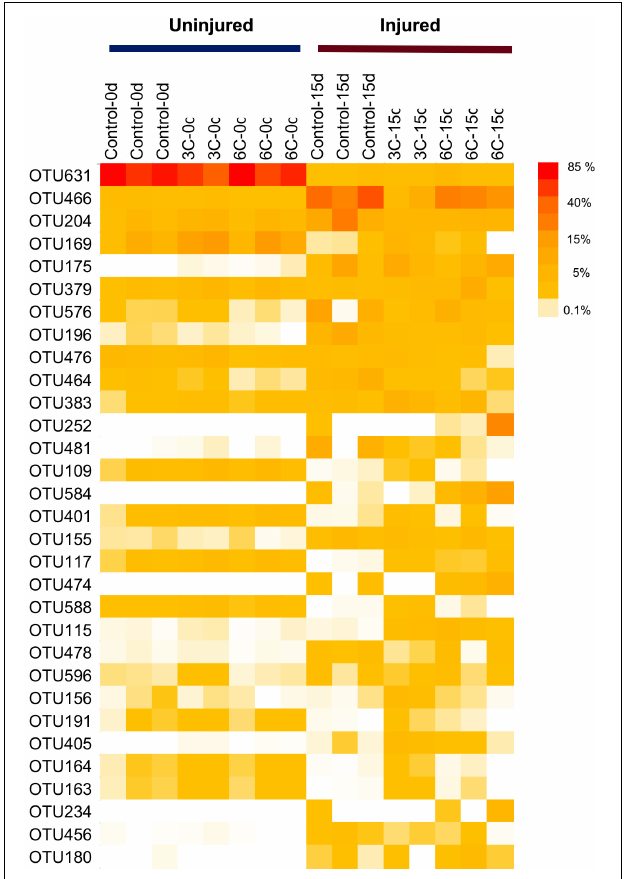
FIGURE 5 | Heat map of the 31 most abundant prokaryotic OTUs associated with Isodictya kerguelenensis individuals and exposed to different experimental